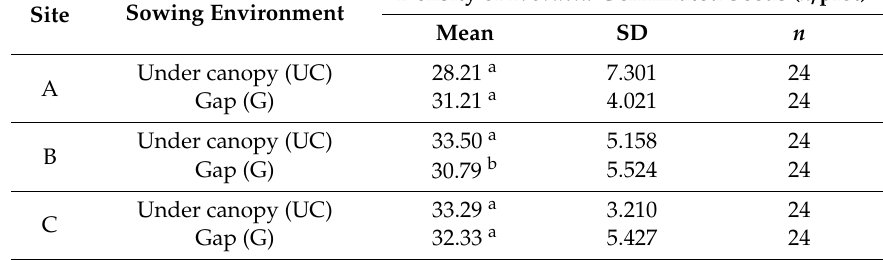
Table 3. Mean density of P. brutia germinated seeds in the early sowing period (ESP–December) in the plots that were established in the under canopy and in gap sowing environments in each of the three sites.